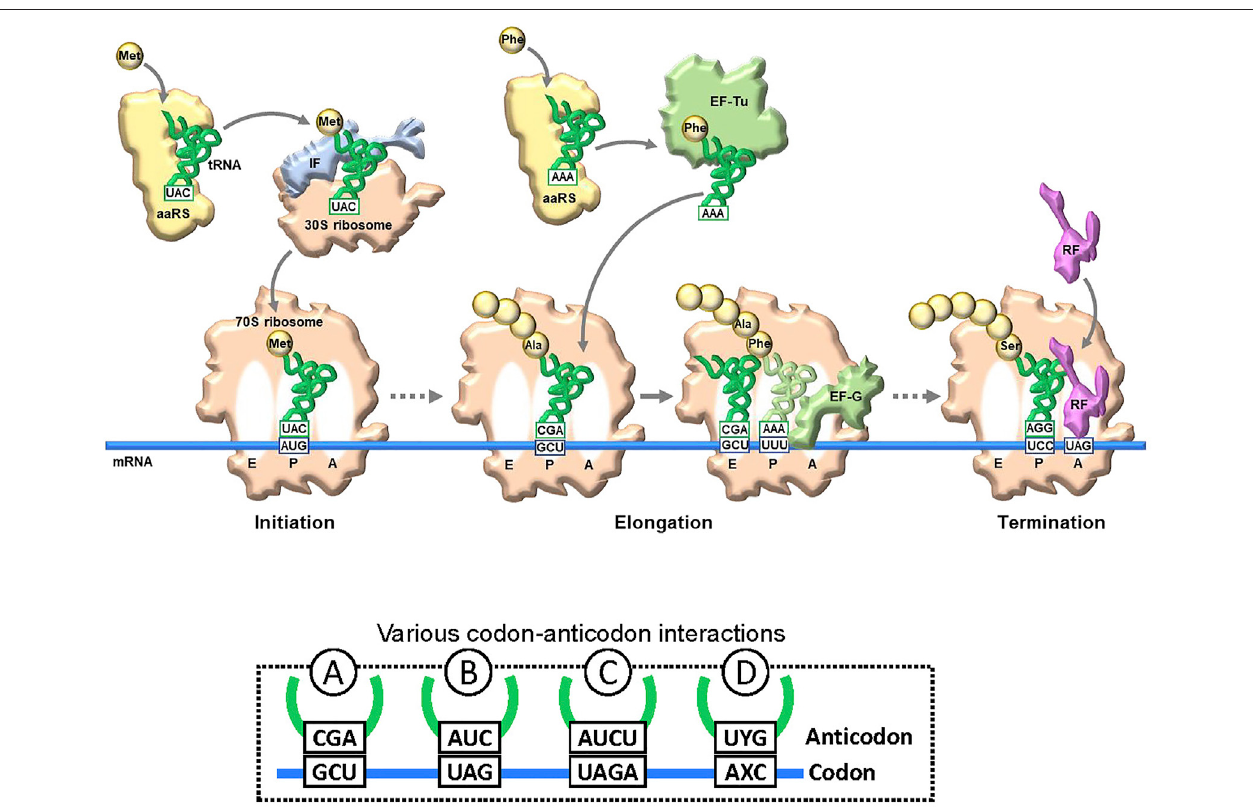
FIGURE 2 | Translation and codon-anticodon interactions. Simpli fi ed illustration of translation fl ow from initiation to termination. The representative key components are schematically illustrated. aaRS: aminoacyl-tRNA synthetase. tRNA and mRNA are shown in blue and green lines, respectively. To decode a speci fi c amino acid, a new codon-anticodon is required. Examples of four different codon-anticodon interactions for (re)assignment of an unnatural amino acid (unAA). A: usual natural codon; B: stop codon (UAG); C: four-base codon (quadruplet codon); D: unnatural-base codon.